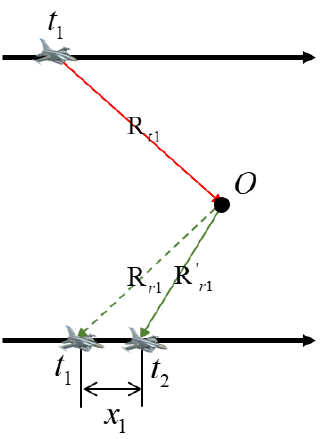
Figure 6. Non-“stop and go”